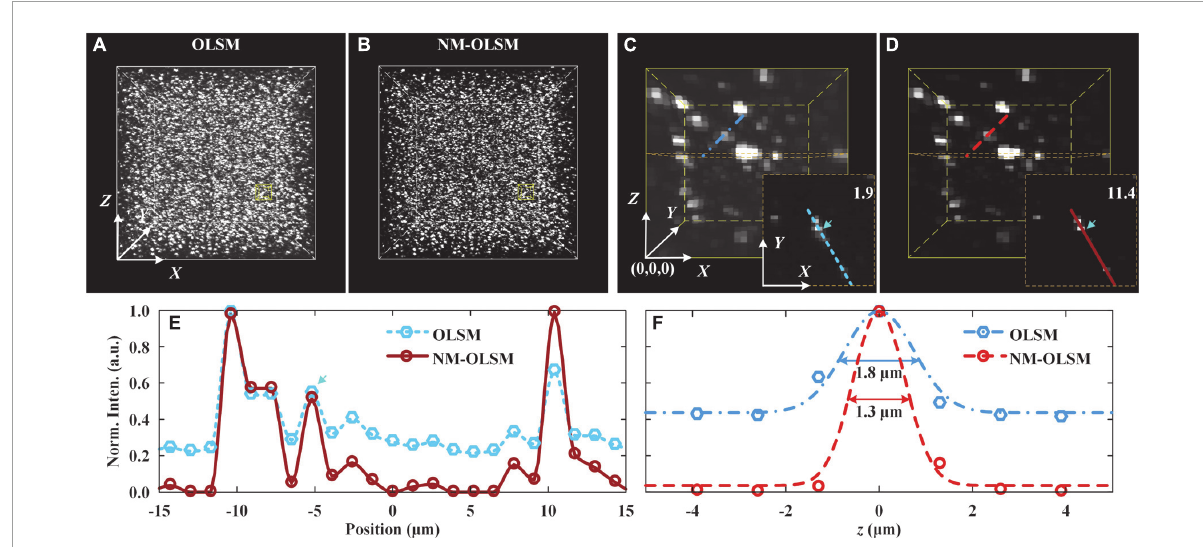
FIGURE4 Images of agarose-embedded 200-nm-diameter fluorescent beads. (A,B) Visualizations of 0.3 mm × 0.3 mm × 0.3 mm image stacks were captured by ILSM and NM-ILSM, respectively. (C,D) Expanded views of 30 × 30 × 40-pixel subblock of the stacks in (A,B) , respectively. The subimages at the lower right corners show the planes at Z = 20.2 µ m of the subblocks. (E) Normalized intensity distribution across several beads outlined in (C,D) . (F) Normalized intensity distribution along the z -axis of the typical